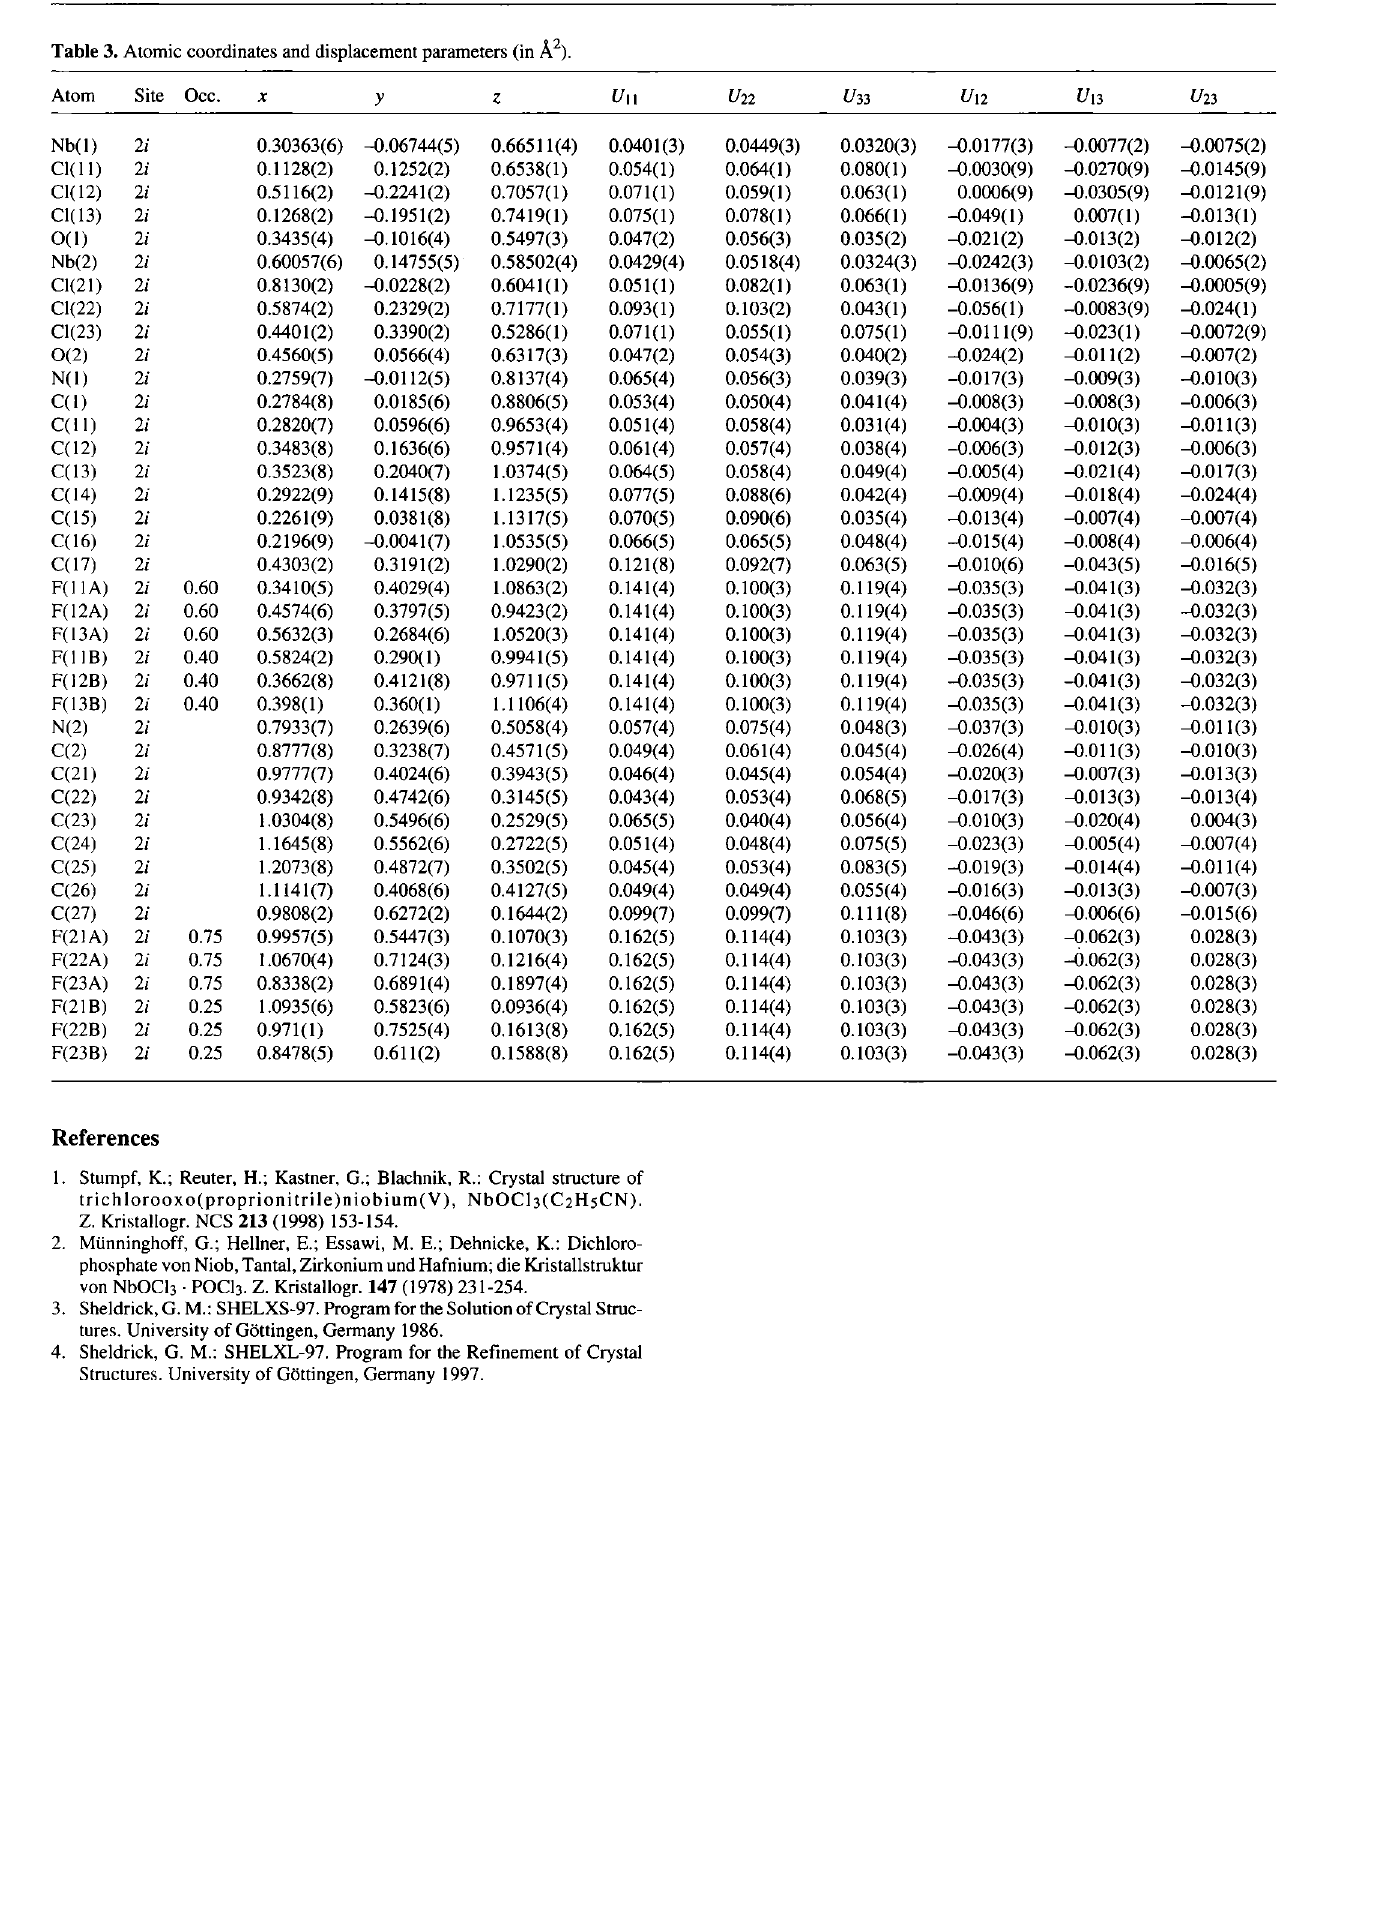
Table 3. Atomic coordinates and displacement parameters (in Â 2 ). Atom Site